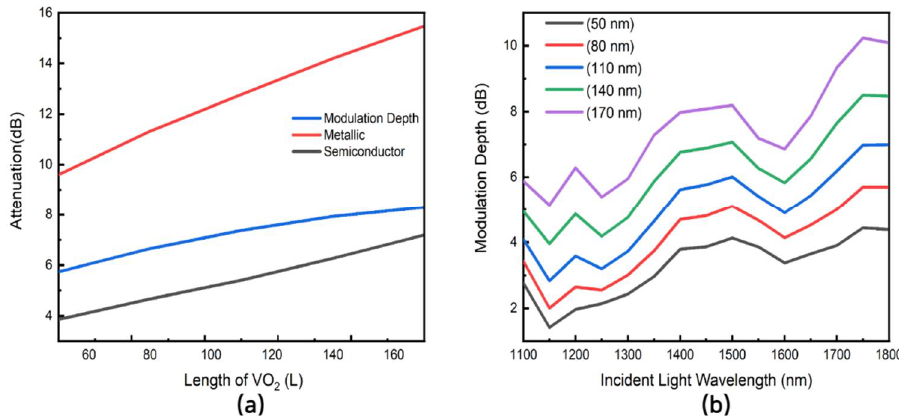
Figure 4. ( a ) Attenuation of light of wavelength 1550 nm for both the metallic and semiconductor phases of VO 2 as well as the modulation depth for different lengths of the VO 2 modulating section (L). ( b ) The variation of the modulation depth with different wavelengths of incident light (λ) from 1100 nm to 1800 nm, with the length of the VO 2 modulating section (L) varied from 50 nm to 170 nm.